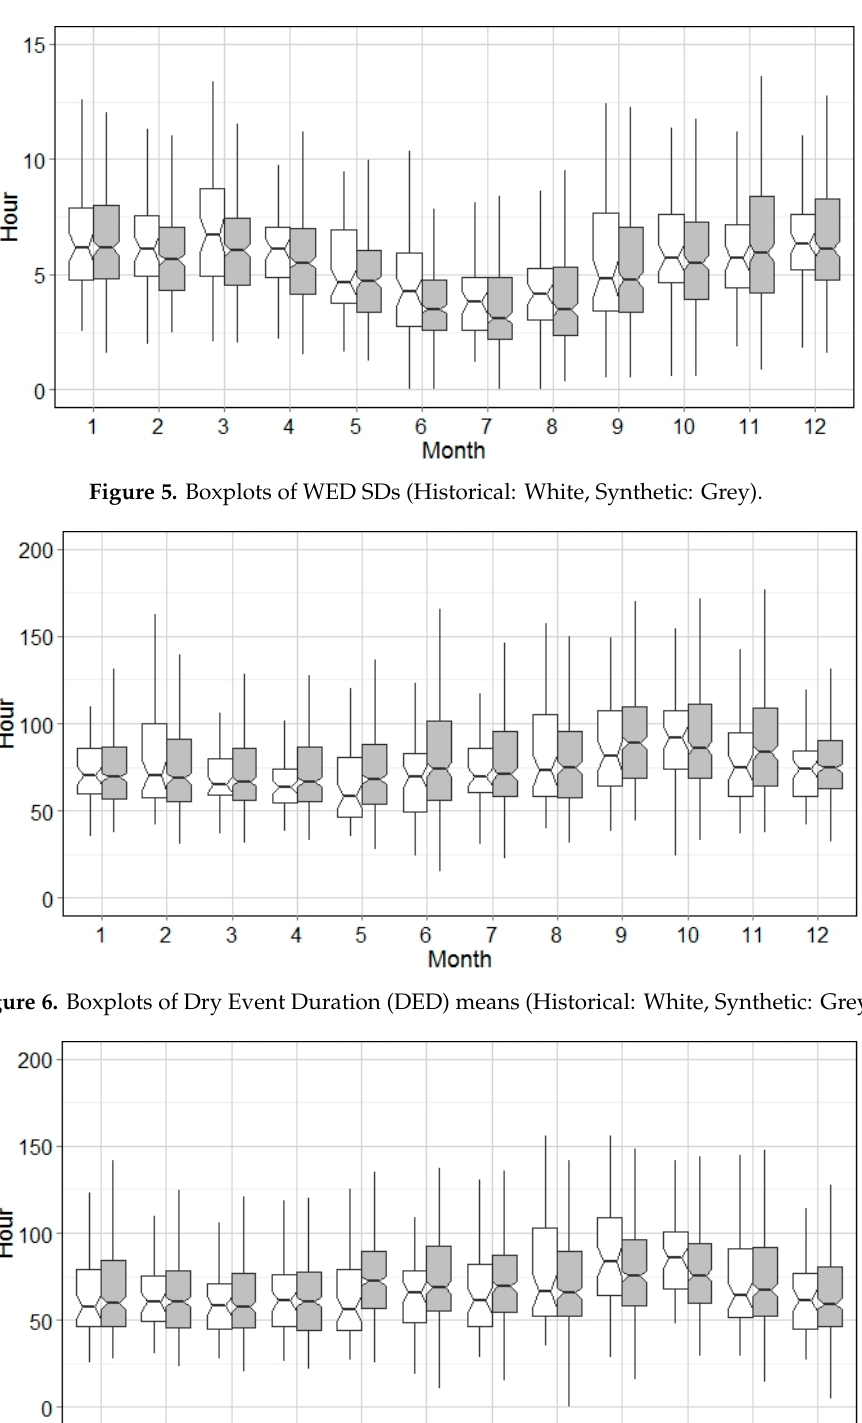
Figure 4. Boxplots of Wet Event Duration (WED) means (Historical: White, Synthetic: Grey).